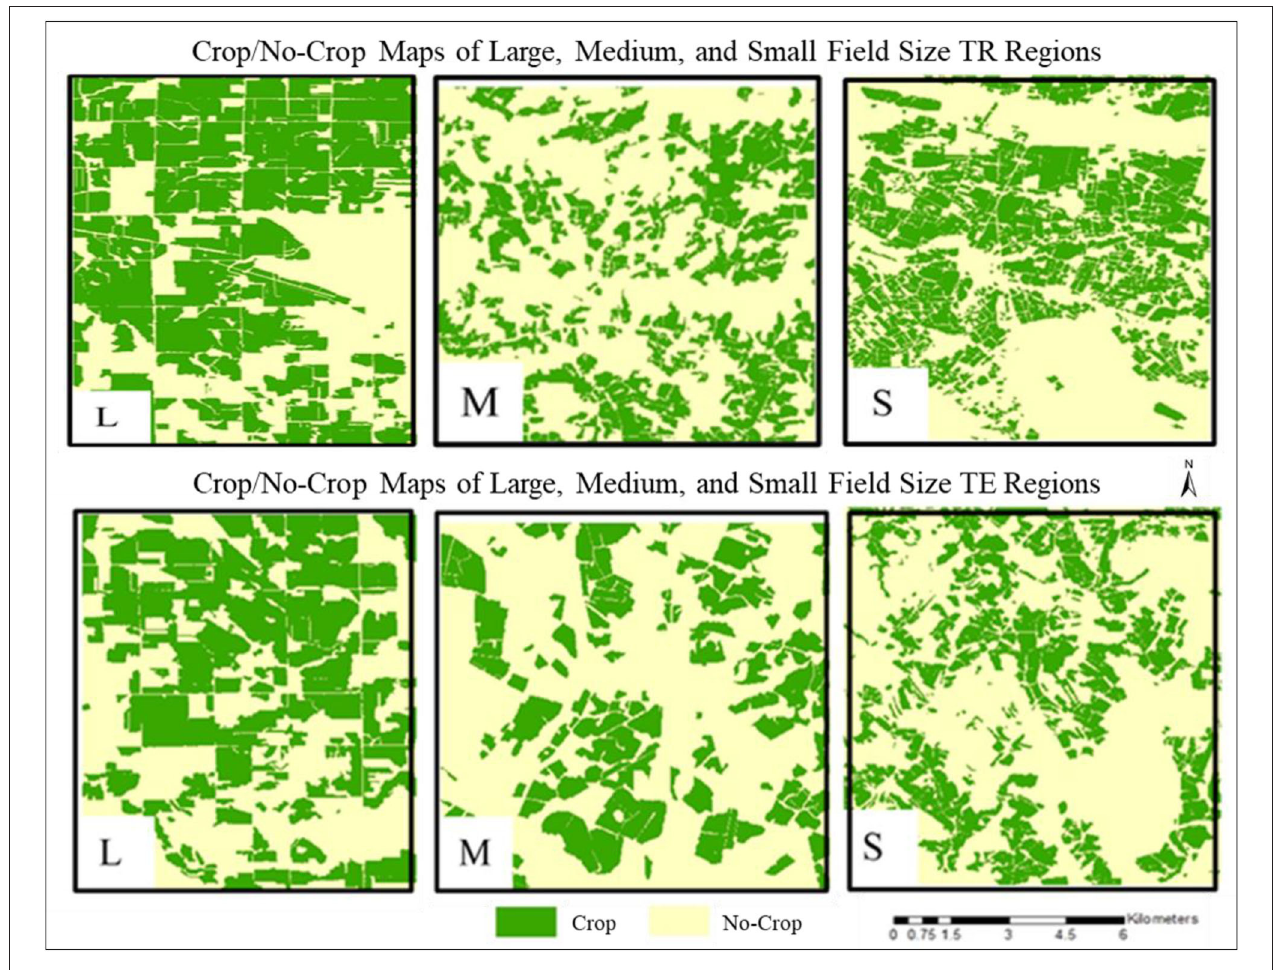
FIGURE 4 | The crop/no-crop maps of the three TR and three TE regions in large (L), medium (M), and small (S) field